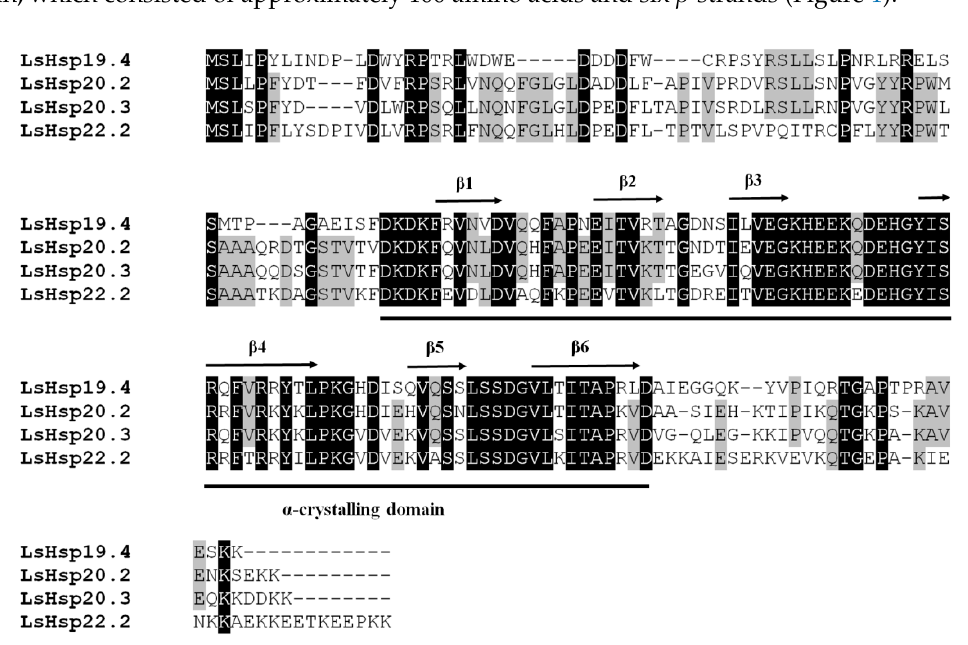
Figure 1. Alignment of the deduced amino acid sequences of four LsHsp genes in L. serricorne . Amino acids with > 50% identities are shaded in gray. Sequences above the black lines are regions of α -crystallin domain. Six β -strands with the α -crystallin domain are indicated with black arrows.